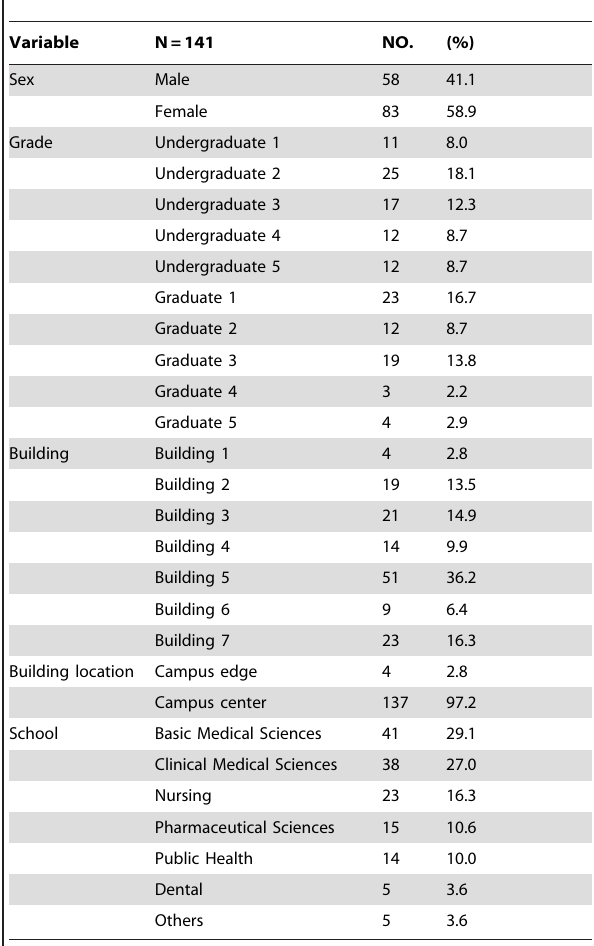
Table 1. Basic information for the study population.